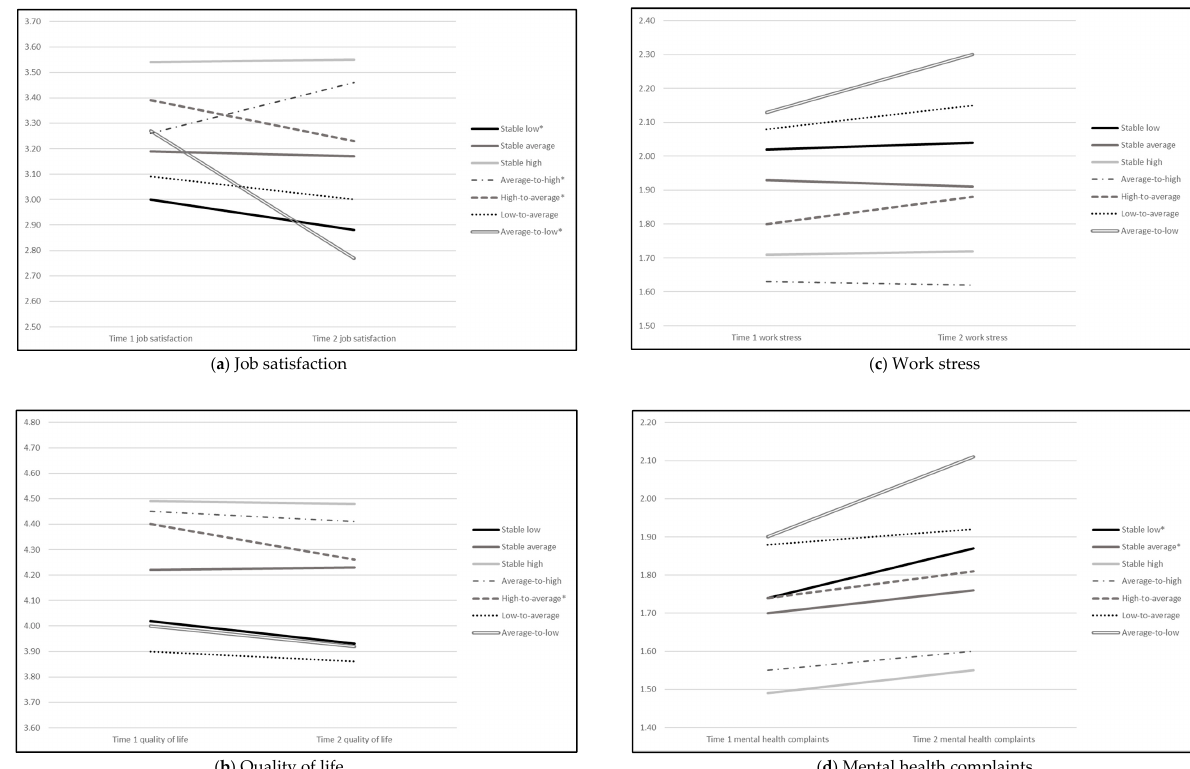
Figure 2. Change in employee well-being across profile transition scenarios. Asterisks in the legend indicate a significant change in a given aspect of well-being from Time 1 to Time 2 in the marked transition scenarios.